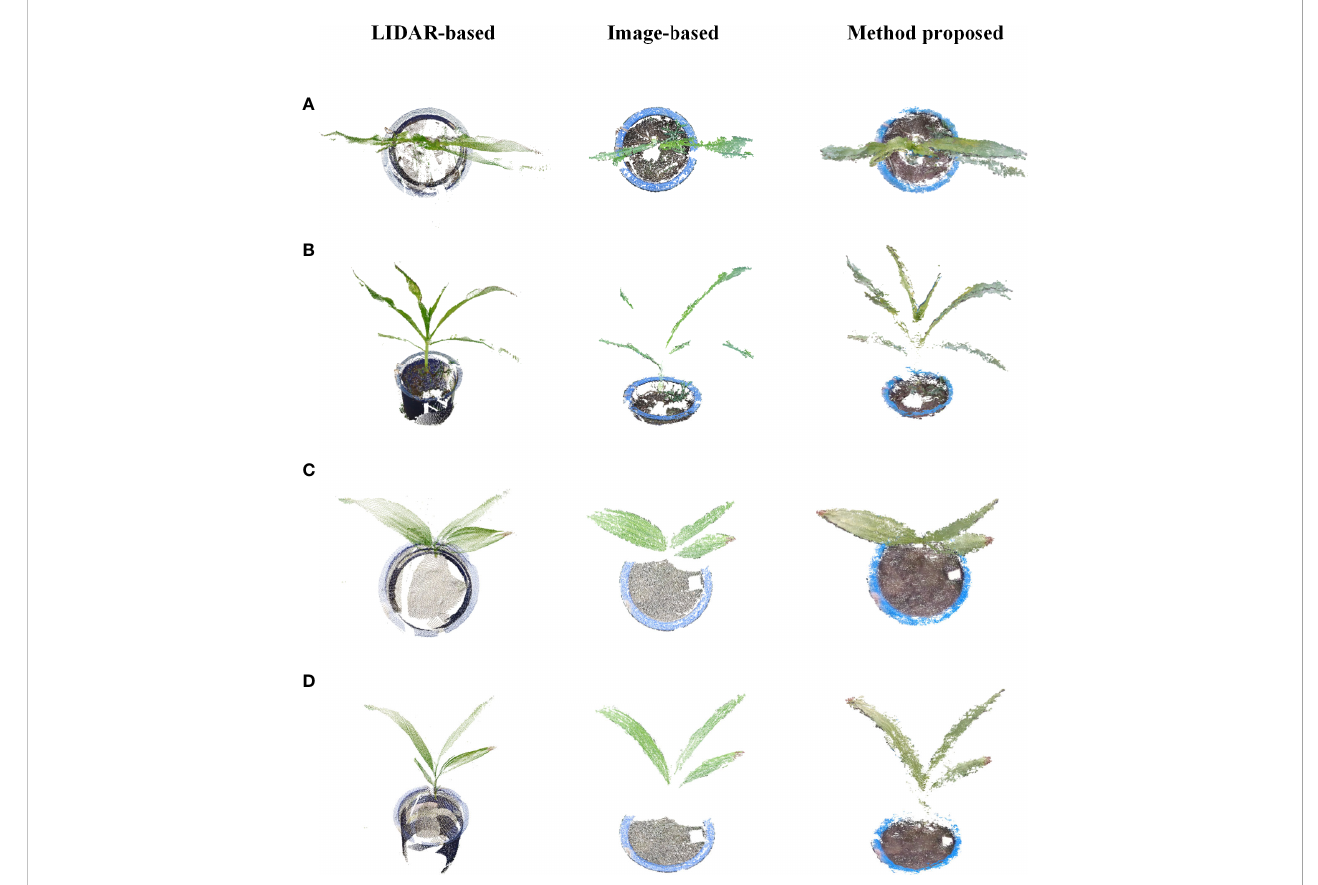
FIGURE 9 Comparison of LIDAR-based, image-based and proposed methods for 3D reconstruction. (A, B) are different views of corn point clouds, and (C, D) are different views of Bletilla striata point